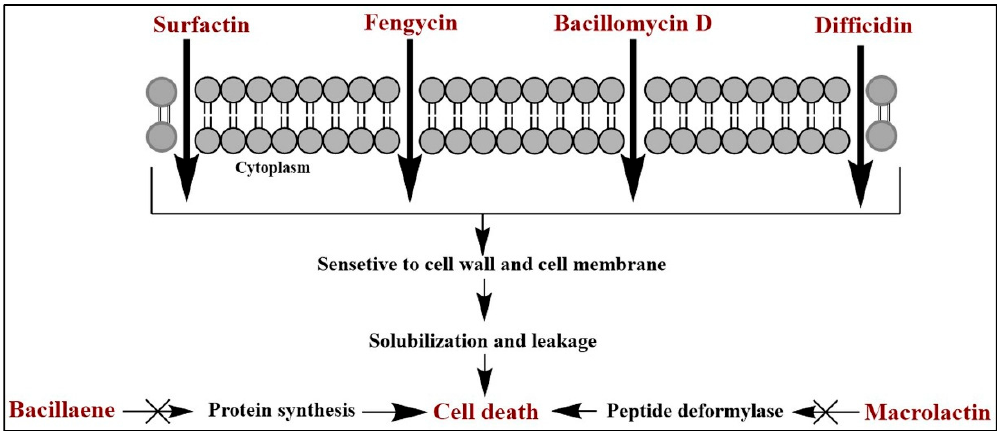
Figure 3. Antimicrobial mechanisms of lipopeptides (LPs) and polyketides (PKs) synthesized by B . velezensis.